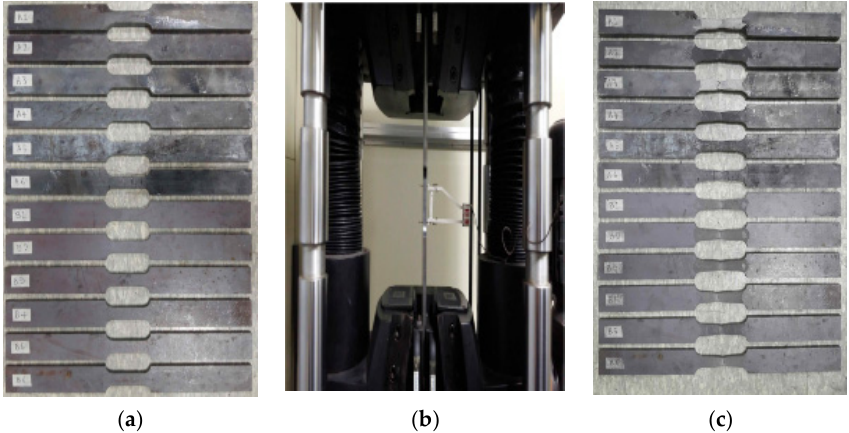
Figure 15. Coupon Test; ( a ) specimens before test; ( b ) test setup; ( c ) specimens after test. Table 5. Material